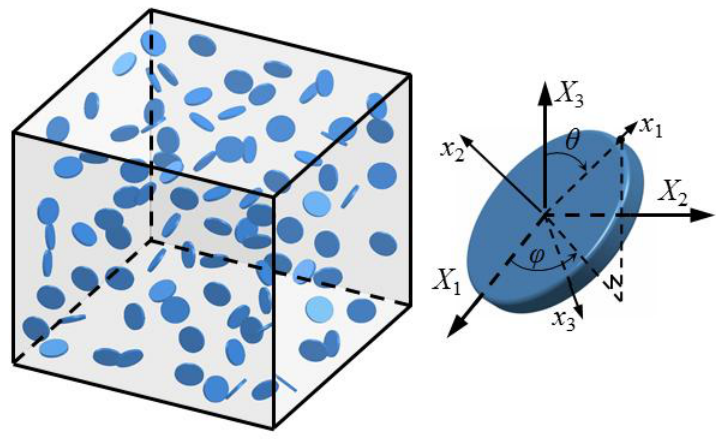
Figure 1. Microscale RVE and characterization of GPL orientation.